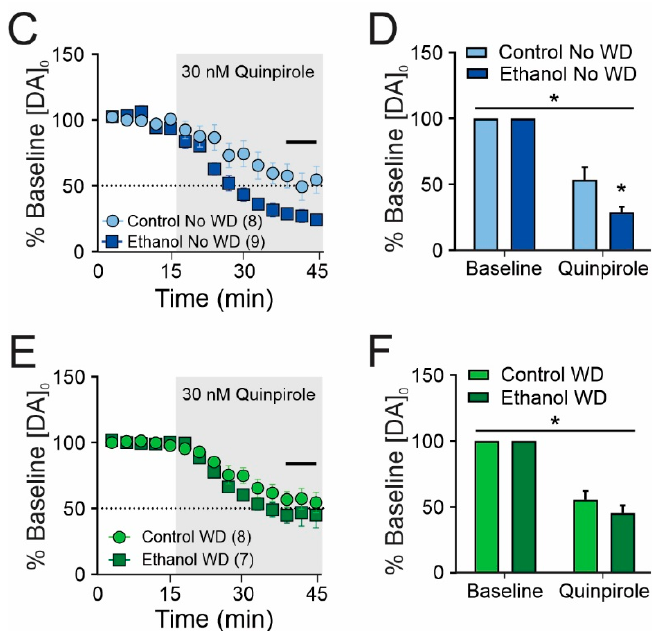
Figure 4. Chronic two-bottle choice ethanol consumption increases D2 dopamine autoreceptor sensitivity. One day of ethanol consumption ( A , B ) did not significantly alter D2 dopamine autoreceptor regulation of dopamine release. However, following four weeks of two bottle choice drinking, D2 dopamine autoreceptors were sensitized, resulting in a greater inhibition of dopamine release upon application of the D2-like dopamine receptor agonist, quinpirole ( C , D ), relative to control groups. This effect was absent in the WD group ( E , F ). The dotted lines in the time course graphs denote the 50% inhibition point. The number of slices for each group are indicated in parentheses and came from 7–9 mice per treatment group. * p <